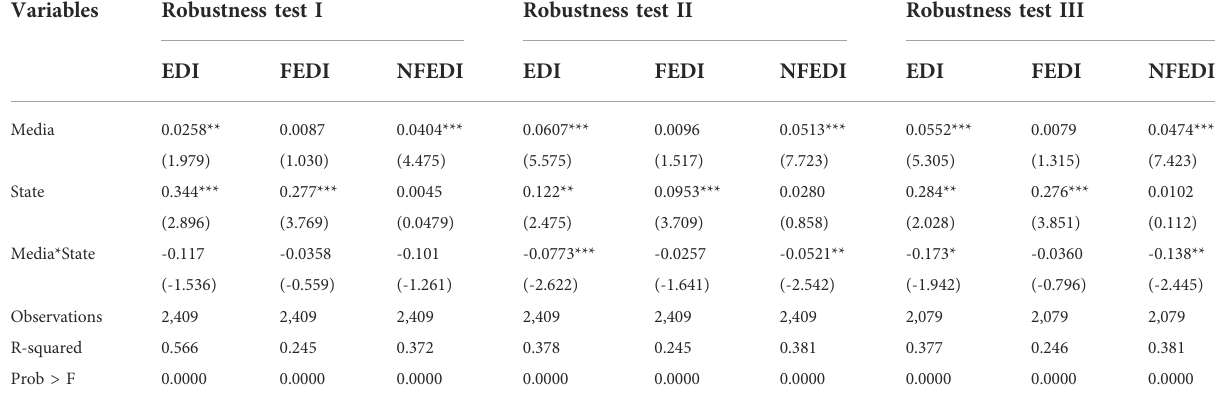
TABLE 8 Robustness